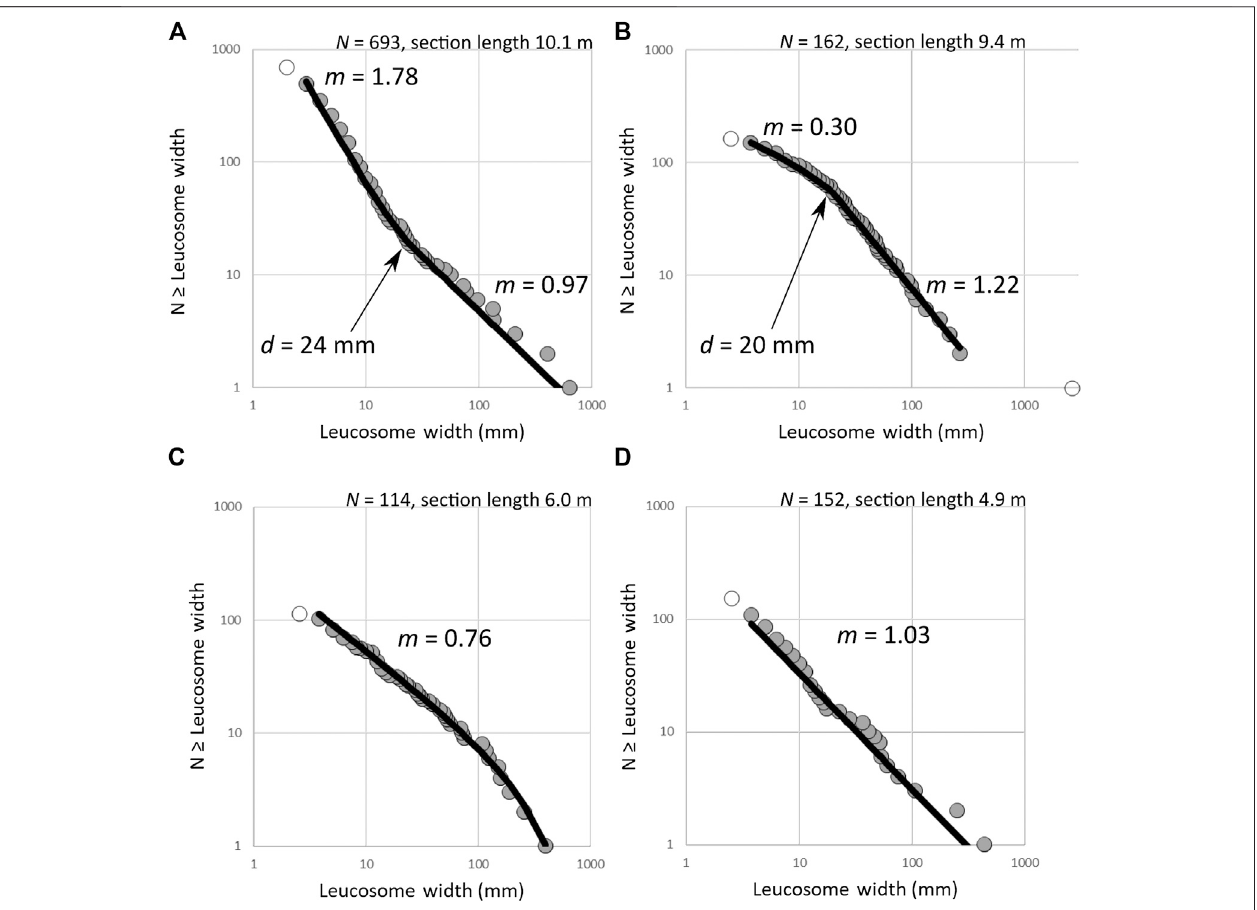
FIGURE 4 | Leucosome width distribution on four different sites on Olkiluoto. The open circles indicate leucosomes not included in distribution determination. (A) OutcropsectionfromaD2shearzonefollowsadoublepower-lawwithanegativekink,showinganunderrepresentationofleucosomesaroundthekinksize d (24 mm)in comparison to both smaller and larger leucosomes. (B) Drill core section 1 follows a double power-law with a positive kink ( d (cid:1) 20 mm), corresponding to an overrepresentation of leucosomes of that size. This section is not from a shear zone. (C) A kink-free truncated power-law distribution fi ts the measurements from drillcoresection 2.Thissection isfrom thecentral parts ofaD3shearzone. (D) Drillcoresection 3appears tofollow anuntruncatedpower-law distribution. Thissection is not close to a shear zone. The Supplementary Material shows the other distributions considered for the measurement data.